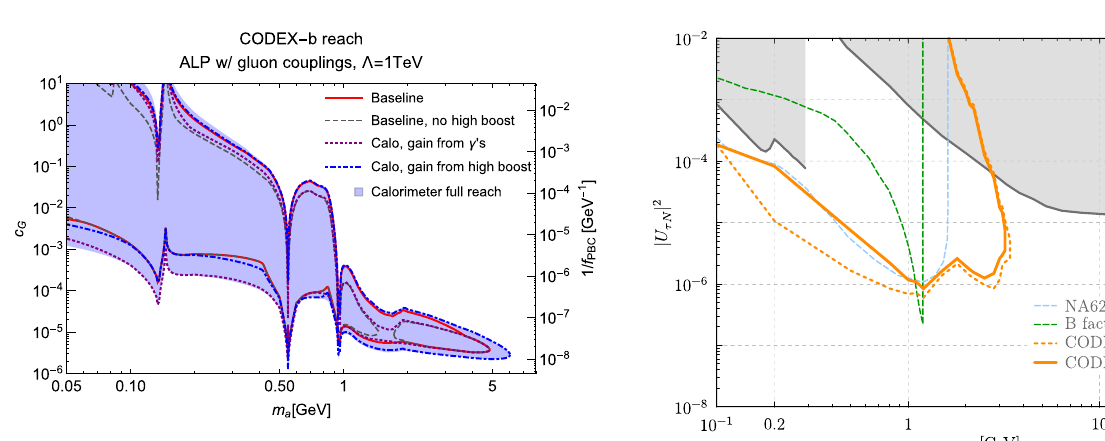
Fig. 34 Projected sensitivity of CODEX-b to gluon-coupled ALPs with a calorimeter element (blue, shaded) compared to the baseline, i.e. tracking only, detector (solid red). Also shown are the gains in reach coming from the ability to detect highly boosted LLPs (blue, dot- dashed) and from the ability to reconstruct photon final states (purple, dotted) separately. The gray dashed line corresponds to the baseline detector reach in which highly boosted ALPs are discarded instead of being considered with 50 events of background